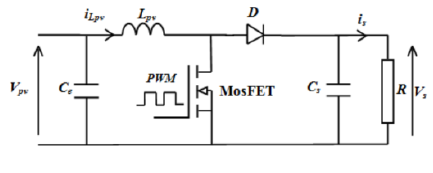
Fig. 6. Boost converter